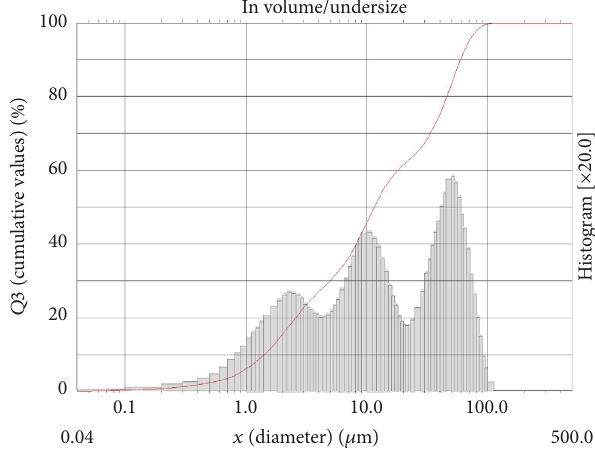
Figure 2: Particle size distribution of the zirconium-based ferro- magnetic sorbent.